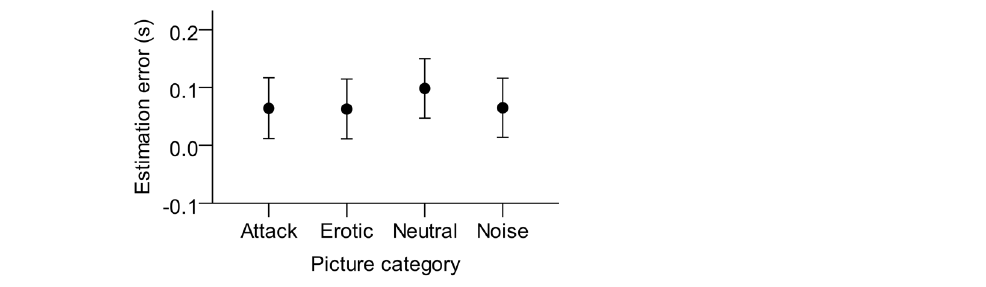
Table 1. Significant main and interaction effects of type 3 F -tests on mean constant errors. p -values and degrees of freedom in the table incorporate Huynh–Feldt correction if appropriate. df Num = numerator degrees of freedom. df Den = denominator degrees of freedom. η p 2 = partial eta-squared.